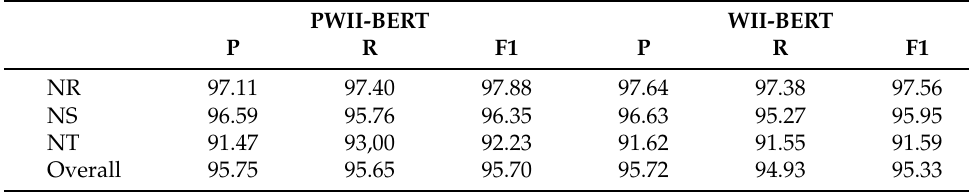
Table 8. Results of P, R, and F1 score on the MSRA dataset.